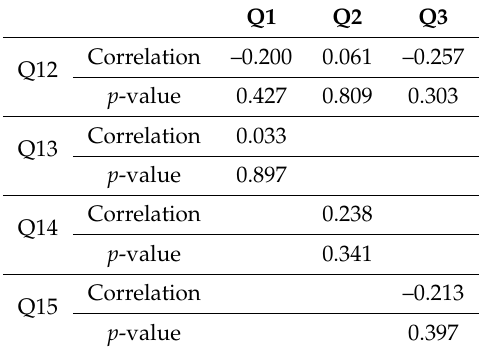
Table 3. Significant correlations between machine learning tools and feature extraction (Q12).